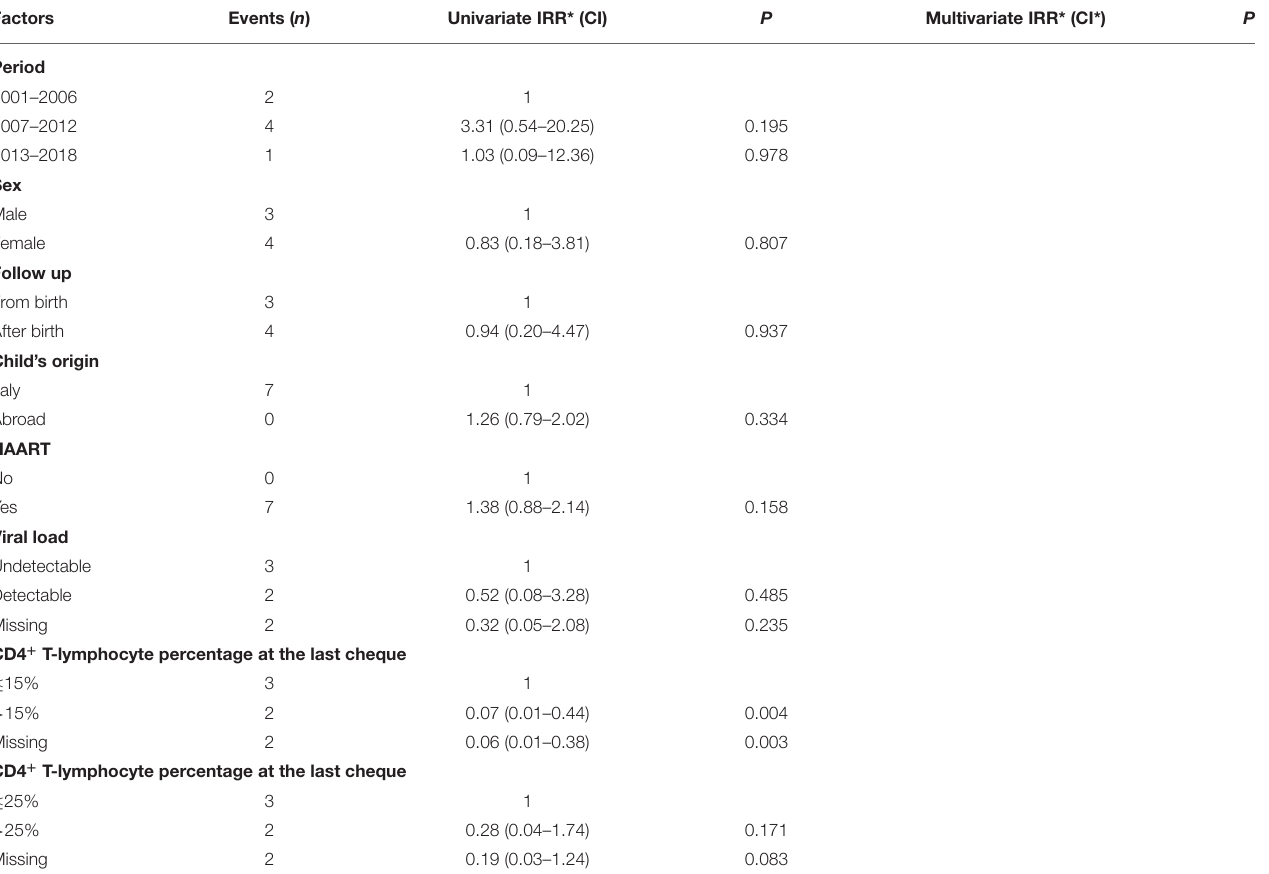
TABLE 9 | Malignancies rates among the study periods, adjusted for sex, starting of follow up, child’s origin, use of HAART, viral load and CD4 + T-lymphocyte percentage (Poisson regression model).